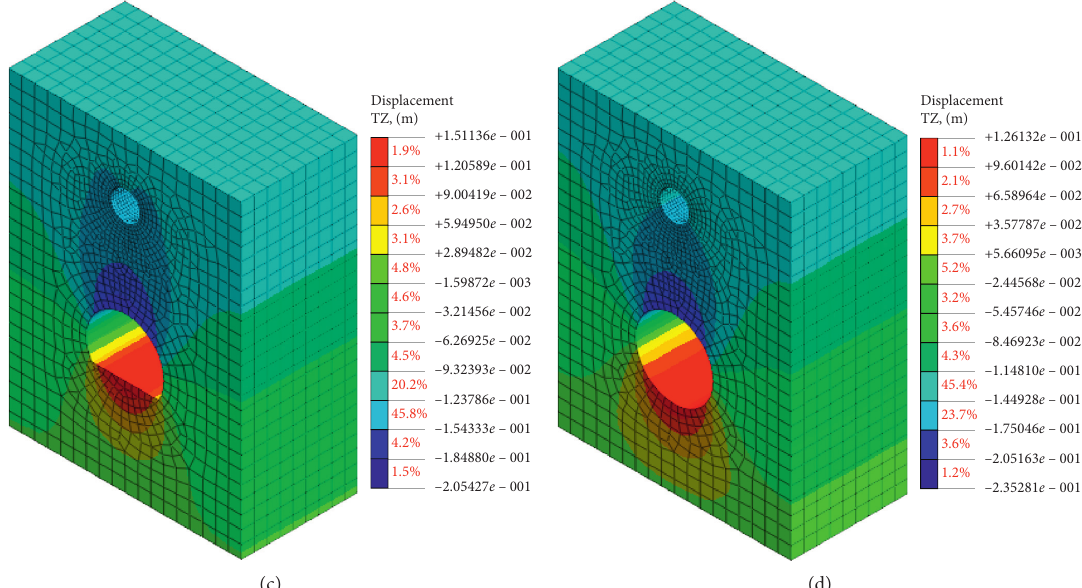
Figure 16: Vertical displacement cloud map of the ground caused by tunnel excavation with cavity. (a) Step 1. (b) Step 2. (c) Step 3. (d) Step 4.